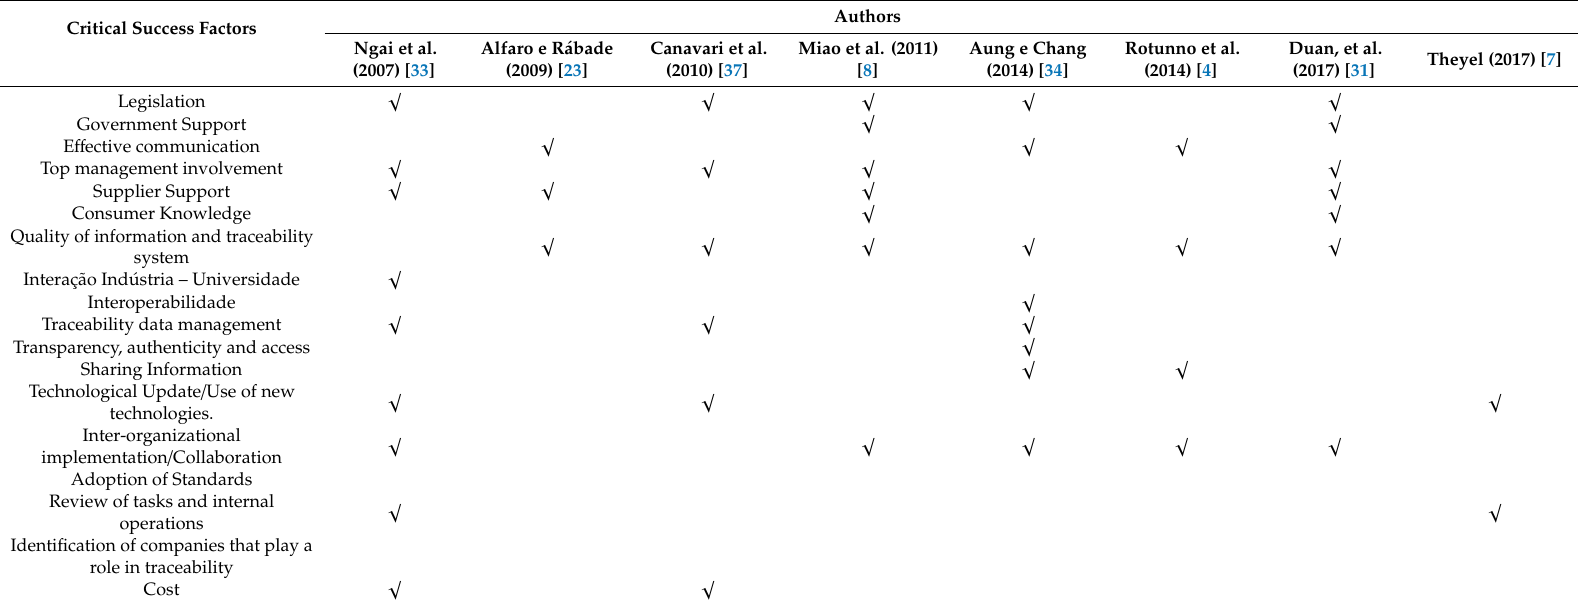
Table 1. Critical success factors (CSFs) for the development of a drug traceability